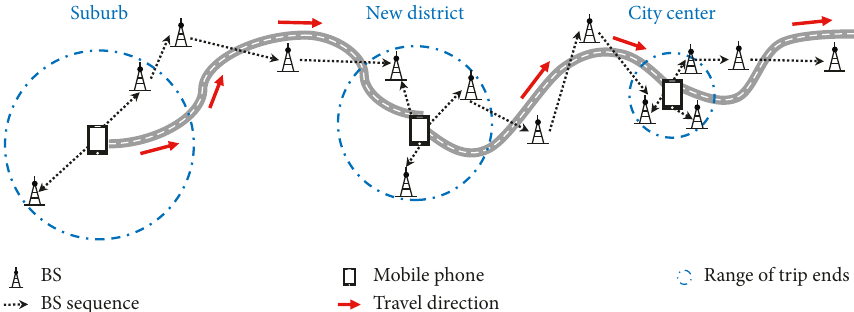
Figure 2: Spatial distribution of traces at trip ends under different BS